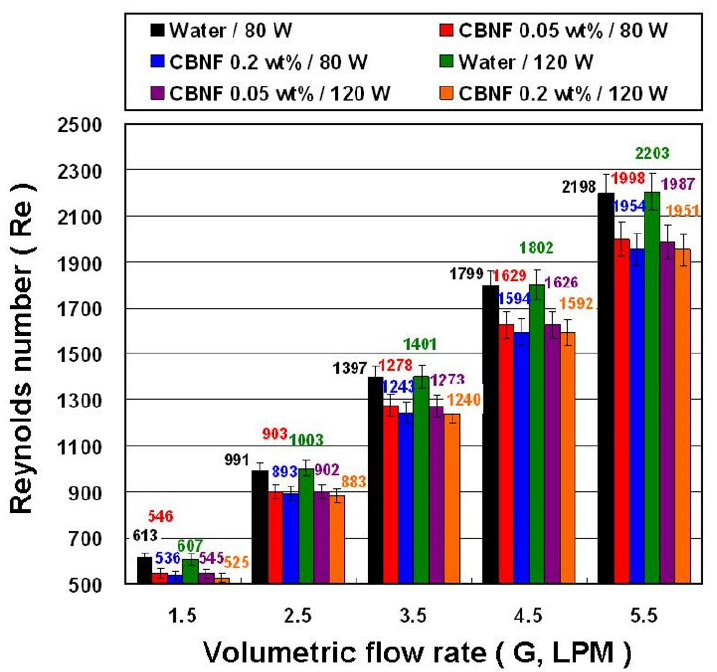
Figure 4. The Re of test samples for THE at various experimental parameters.